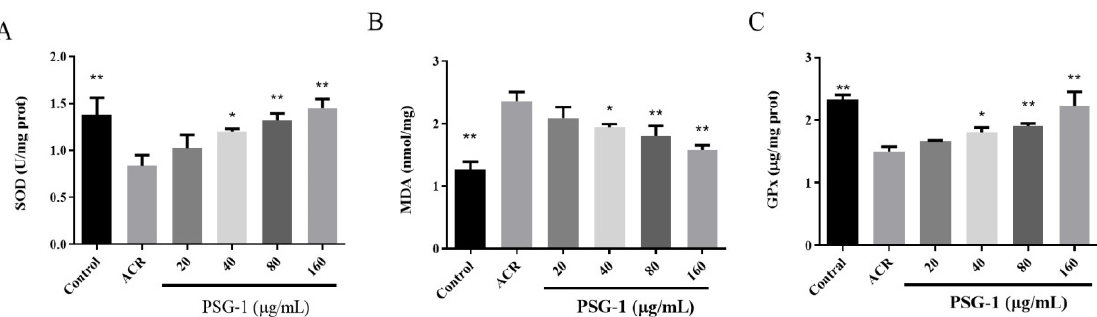
Figure 2. PSG-1 regulated acrolein-induced SOD, MDA, and Gpx. The oxidative state of IEC-6 cells, following acrolein (40 μ M) and PSG-1 (20, 40, 80, and 160 μ g/mL) treatment, was determined by measuring SOD ( A ), MDA ( B ) and GPx ( C ).Values are means ± SD ( n = 3), * p < 0.05, ** p < 0.01 versus the acrolein group.